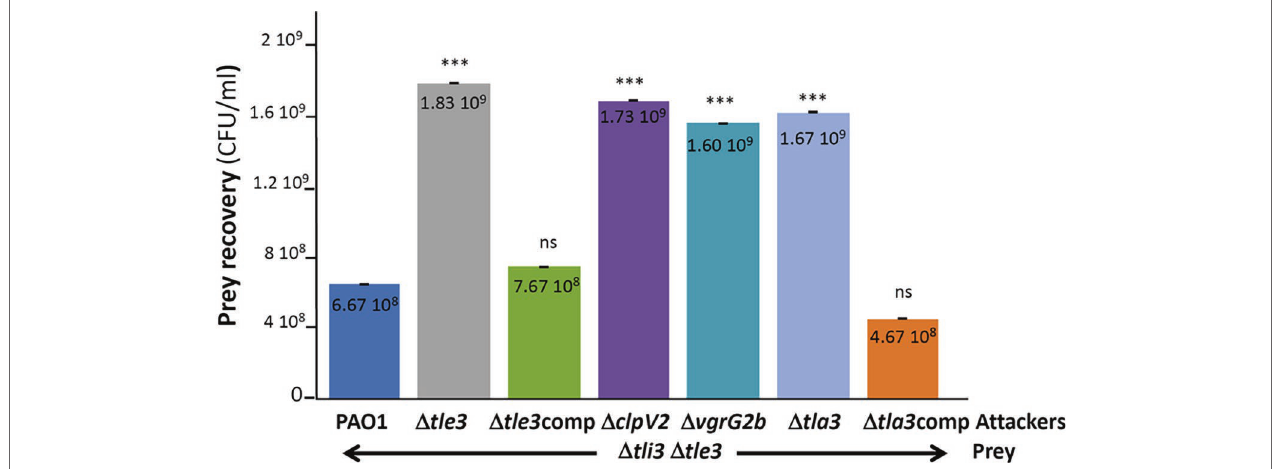
FIGURE 6 | P. aeruginosa growth competition. The P. aeruginosa prey strain (Δ tli3 Δ tle3 ) was incubated with various P. aeruginosa attacker strains as indicated in the figure for 24 h at 37 ° C. The number of recovered prey bacteria is indicated in CFU/ml. “comp” stand for cis complementation of the corresponding mutation with a wild-type copy inserted at the attB site on P. aeruginosa chromosome. Error bars represent ± SEM ( n = 3); *** p < 0.001, ns not